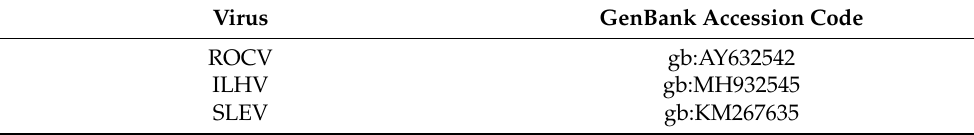
Table 1. GenBank accession codes.